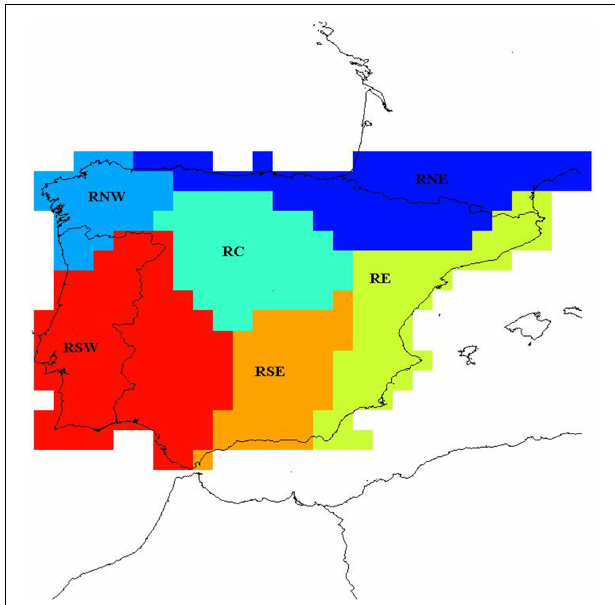
FIGURE 7 | Six main homogeneous regions over